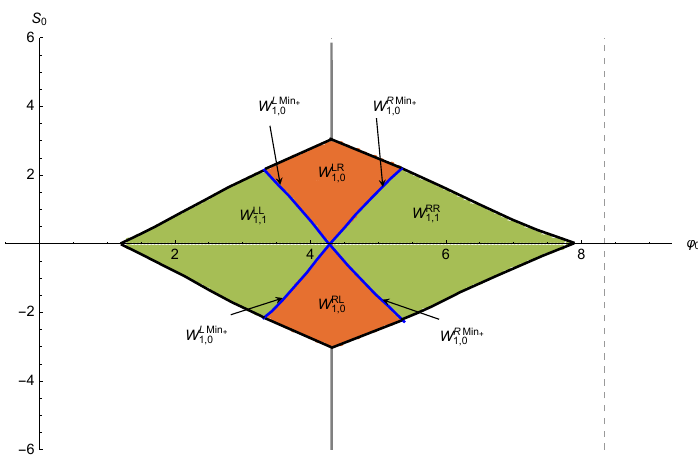
(the orange region), W LL 1 , 0